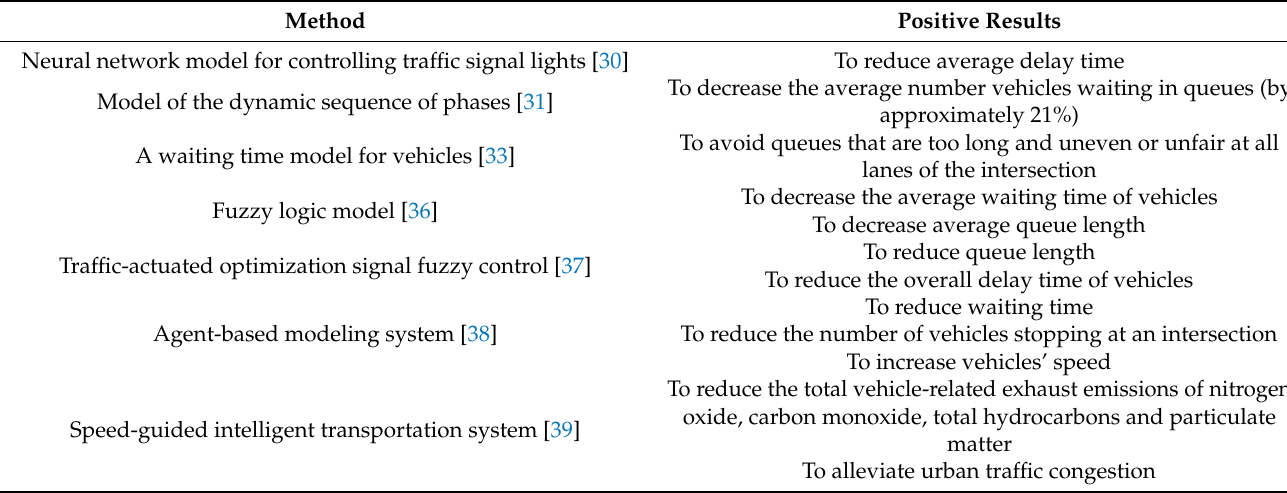
Table 1. Traffic light control methods and their main